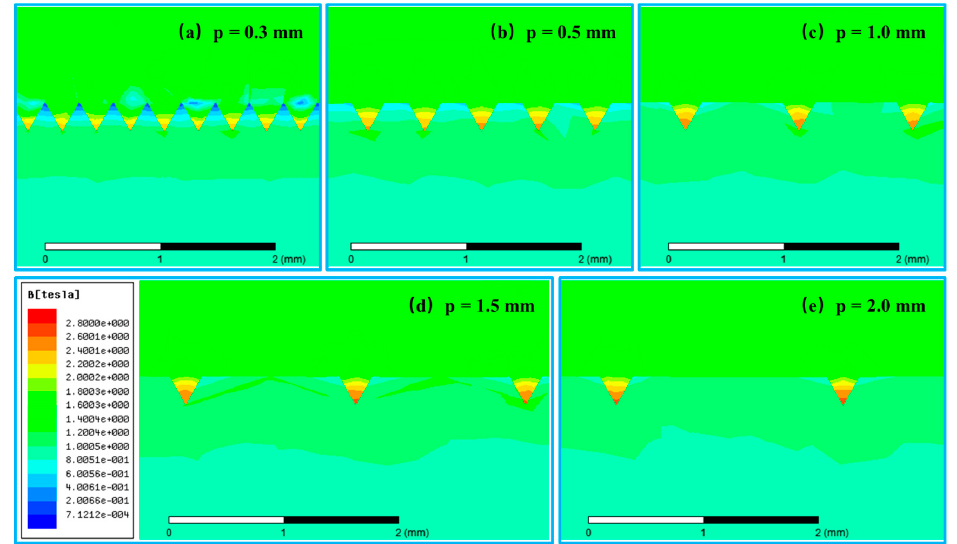
Figure 10. The cloud chart of magnetic induction intensity distribution based on different distances between ERB. ( a ) Distance between ERB p = 0.3 mm. ( b ) Distance between ERB p = 0.5 mm. ( c ) Distance between ERB p = 1.0 mm. ( d ) Distance between ERB p = 1.5 mm. ( e ) Distance between ERB p = 2.0 mm.